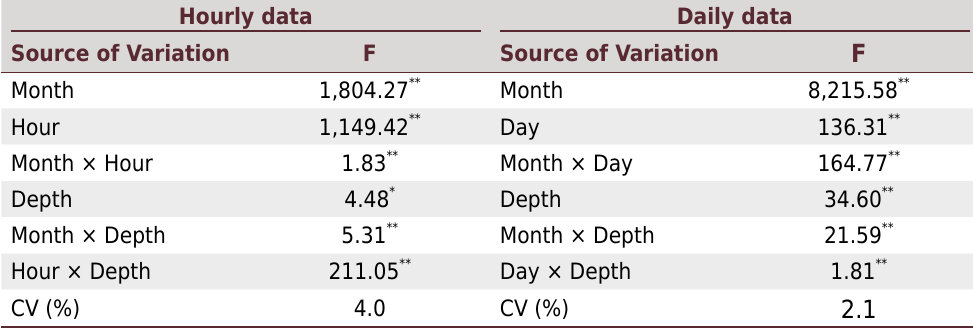
Table 2. F-test of analysis of variance for hourly and daily soil temperature data at three depths of a Cambissolo Háplico Ta Eutrófico (Cambisol; Inceptisol) from February 04, 2014, to September 30, 2015, in São Gabriel, Irecê Identity Territory, Bahia,